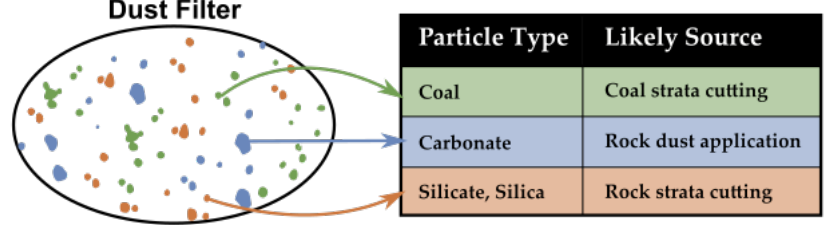
Figure 1. Conceptual illustration of major RCMD sources and particle types.